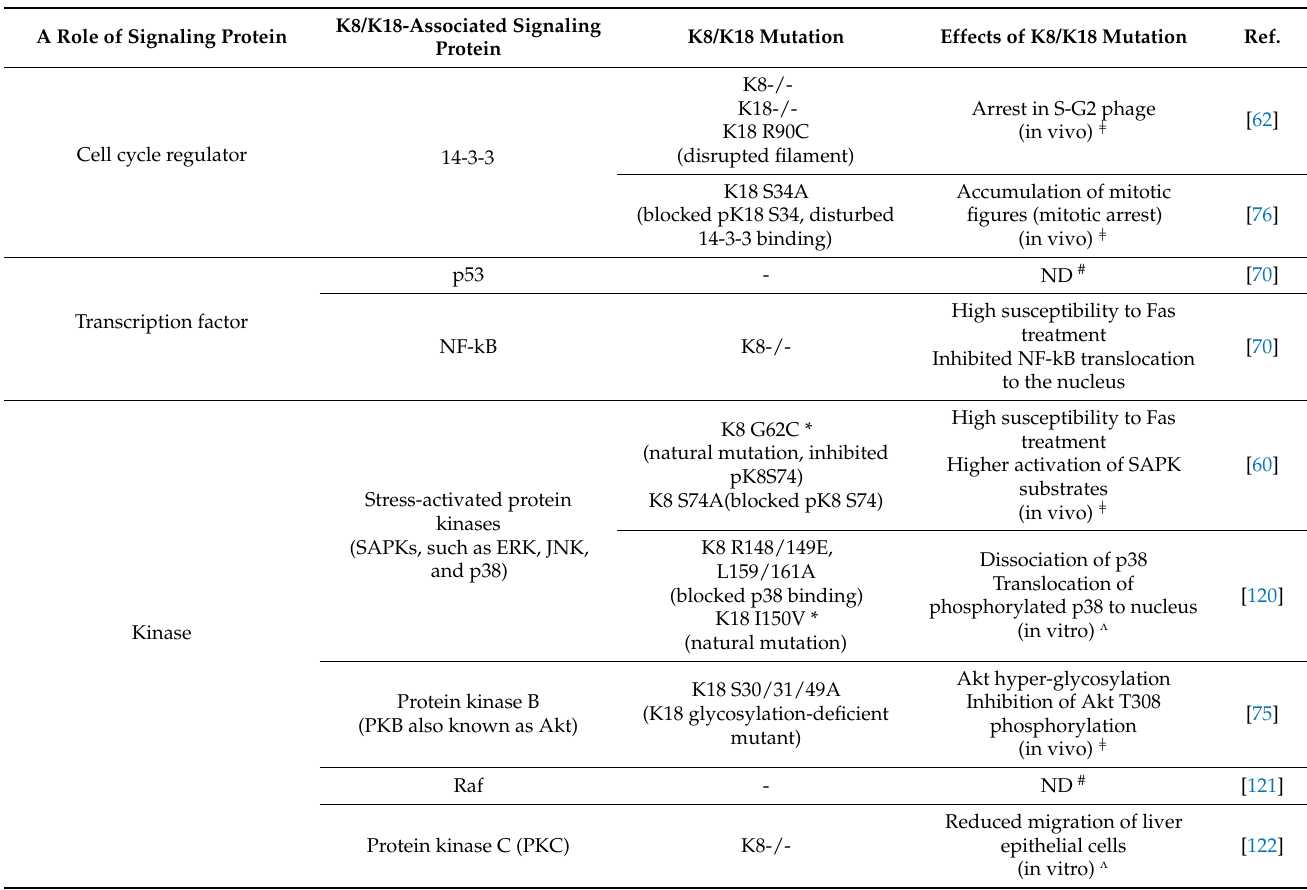
Table 5. K8/K18-associated proteins in signaling